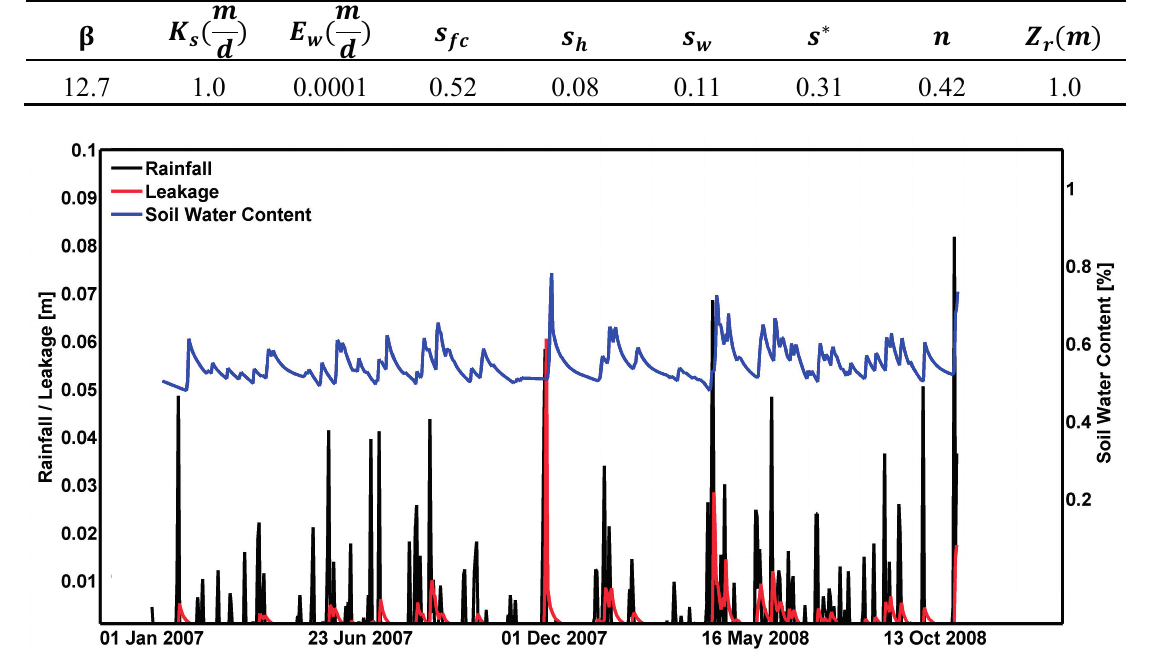
Figure 4. Simulated time series of soil water content (blue line) and leakage (red line) at the position ( x utm = 667,798; y utm = 5,124,101) of the Adige valley. Precipitation is also shown (black